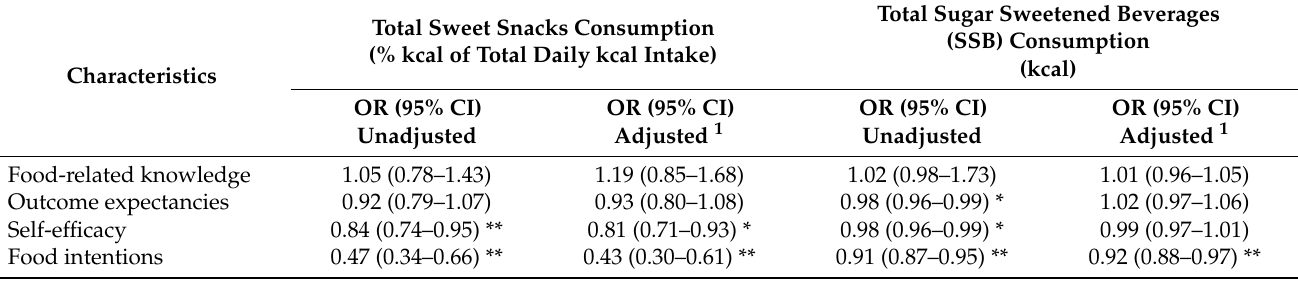
Table 3. Multiple linear regression results of sweet snacks and sugar sweetened beverages (SSB) consumption on psychoso- cial factors among African American adolescents aged 9–15 ( n = 437) in the B’More Healthy Community for Kids (BHCK) trial at baseline